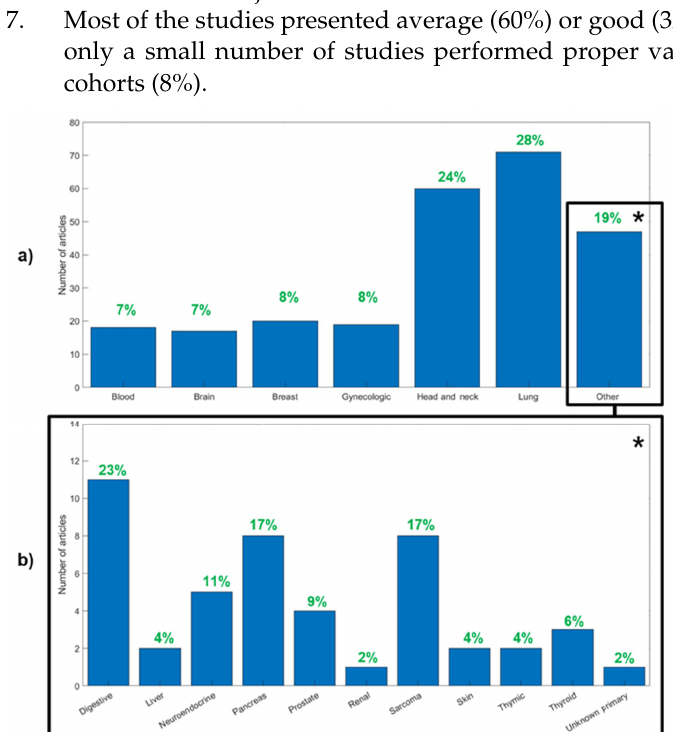
Figure 4. The number of articles associated with each cancer type group. ( a ) Number of patients per number of groups studied in the present review. ( b ) Distribution of cancer types in the “Other” group. In green, the percentage of publications corresponding to that group. * Percentages in panel ( b ) represent the percentage in the “Other” group.